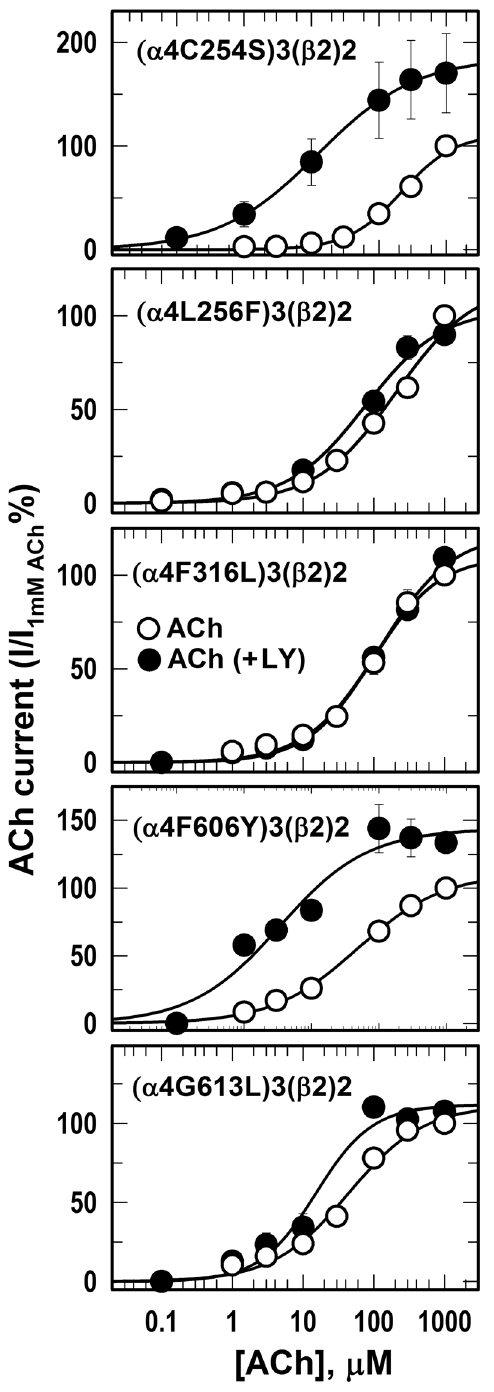
Figure 7. Effect of LY2087101 on the ACh dose-response curve of mutant α 4 β 2 nAChRs. Currents elicited by Xenopus oocytes expressing ( α 4) 3 ( β 2) 2 nAChRs containing point mutation within the α 4 subunit in response to 10-second applications of increasing concentrations of ACh (alone ( ○ ) or + 1 µ M LY2087101 ( ● )) were recorded and normalized to peak currents elicited by 1 mM ACh alone. Replicas from the same oocyte were averaged and the Average ± SE of data from at least 3 oocytes were plotted and fit to a single site model using Equation 1. For ( α 4C254S)3( β 2)2; ( α 4L256F)3( β 2)2; ( α 4S258M)3( β 2)2; ( α 4L260M)3( β 2)2; ( α 4T261D)3( β 2)2; ( α 4F316L)3( β 2)2; ( α 4F606Y)3( β 2)2; ( α 4G613L)3( β 2)2 nAChRs, ACh I max (Ave ± SEM) calculated from the fit of ACh concentration-response curves in the presence of 1 µ M LY2087101 were 185 ± 04; 104 ± 09; 232 ± 10; 264 ± 80; 180 ± 23; 122 ± 13; 144 ± 013; 112 ± 9%, and the probability ( P ) that Imax in the presence of 1 µ M LY2087101 were different from normalized current response to 1 mM ACh alone ( I max = 100) were < 0.001, 0.878, < 0.001, < 0.001, 0.003, 0.475, 0.062, and 0.442,